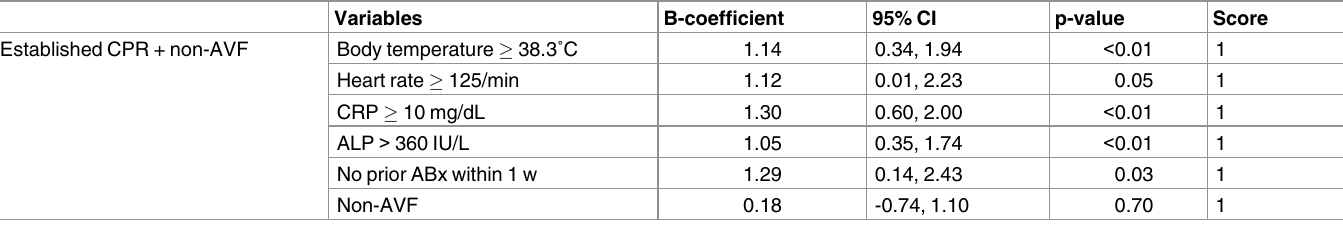
Table 5. Multivariate analysis and scoring for the modified